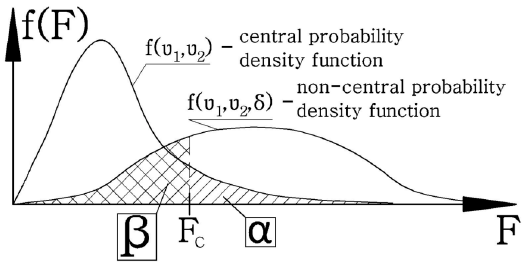
Figure 8. Method of determining the probability of making a second type error ( β ) in DOE analysis based on the example of the analysis of the effect of the independent variable on a dependent variable. While the central F distribution characterizes how the F test statistic is distributed when the null hypothesis is assumed to be true, the non-central F distribution instead shows how the F test statistic is distributed when the alternative hypothesis is assumed to be true (i.e., when the null hypothesis is assumed to be false). As such, it is useful in calculating the power of the usual F tests (ANOVA, regression, etc.) [36]. Knowing the value of the probability of making a second type error ( β ), it is possible to calculate the test power according to Formula (5). It was assumed that the minimum power cannot be lower than 80%, i.e., the probability of making a second type error cannot exceed 20%. In the case of analysis of the non-central distribution F, the big problem is the calculation of the non-central parameter δ (which is calculated from the Root Mean Square Standardized Effect (RMSSE) —Formula (6)). The RMSSE is the square root of the sum of squared standardized effects divided by the number of degrees of freedom for the effect. For individual main effects [33] and two- factor ANOVA interactions, this leads to Formulas (7), (8), and (9), where 𝑆𝑆 (cid:3002).(cid:3032)(cid:3033) , 𝑆𝑆 (cid:3003).(cid:3032)(cid:3033) , 𝑆𝑆 (cid:3002)(cid:3003).(cid:3032)(cid:3033) are respectively the sum of the squares of the mold main effect, hot fill main effect, and interaction effect. The variance σ e 2 is the highest possible probability of the measurement uncertainty value of the measurement for the test object in the measurement series (calculated according to Formula (10)). 𝛅 𝐞𝐟 = 𝐍 𝐞𝐟 ∙ 𝐝𝐟 𝐞𝐟 ∙ 𝐑𝐌𝐒𝐄𝐄 𝐞𝐟𝟐 .